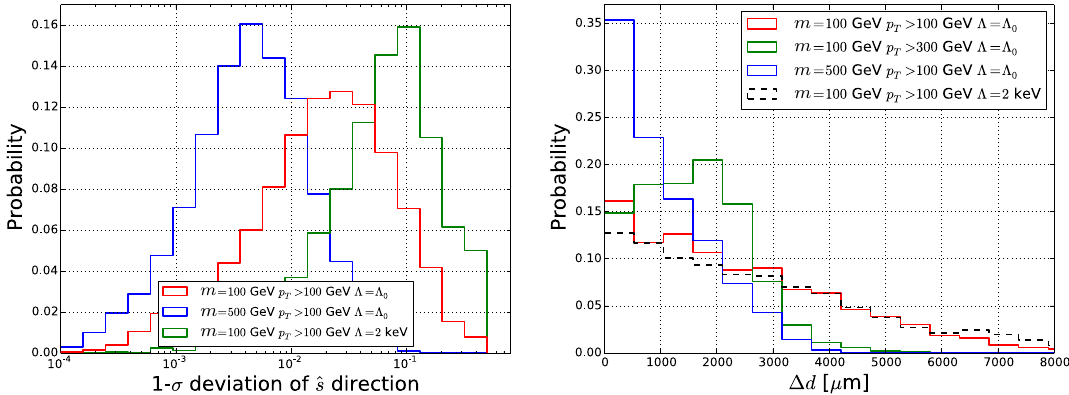
Fig. 6 Left: the distributions of standard deviations of the s angles for different quirk production processes. Right: the difference of quirk pair plane thickness between taking fixed ˆ s and true ˆ s respectively in solving quirk EoM